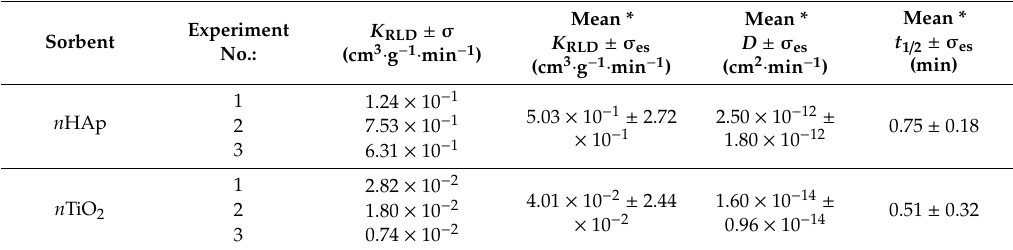
Table 5. The values of over-all kinetic, K RLD , and di ff usion, D , coe ffi cients, and half-life of sorption, t 1 / 2 , for the di ff usion in reacted layer (RLD)